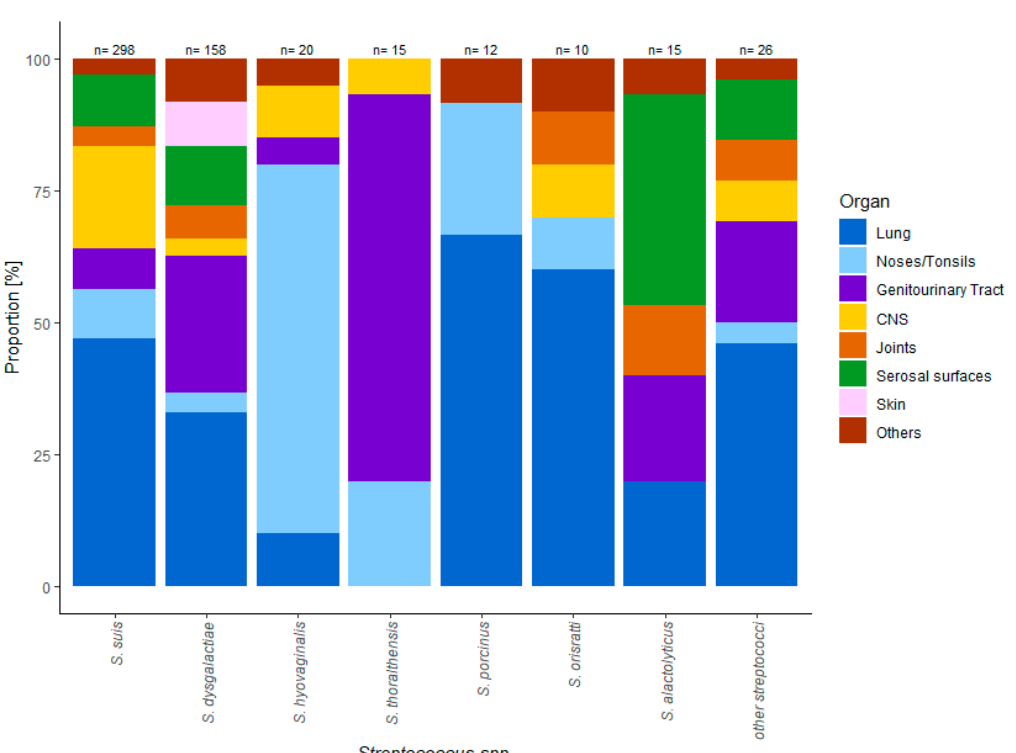
Figure 1. Organ distribution of different Streptococcus spp. isolates.